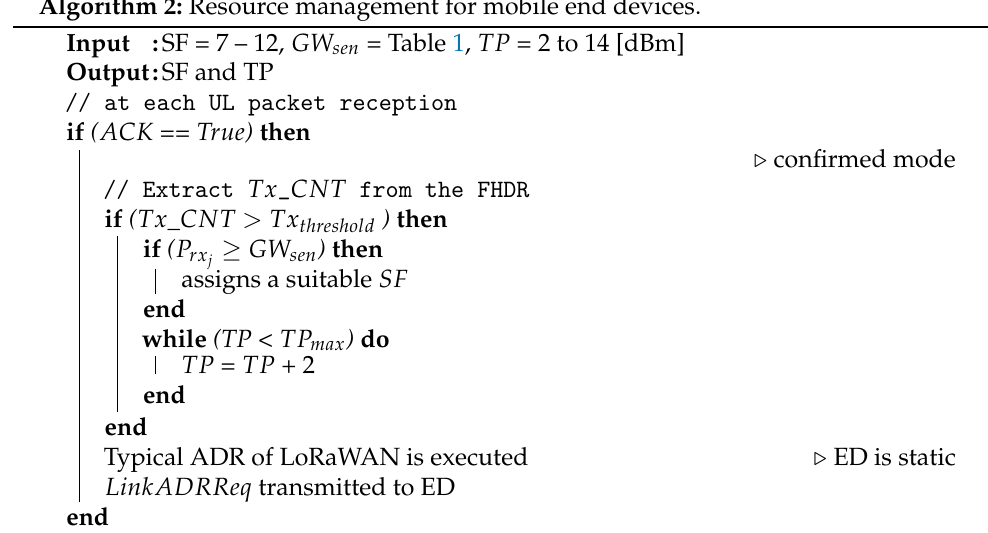
Algorithm 2: Resource management for mobile end